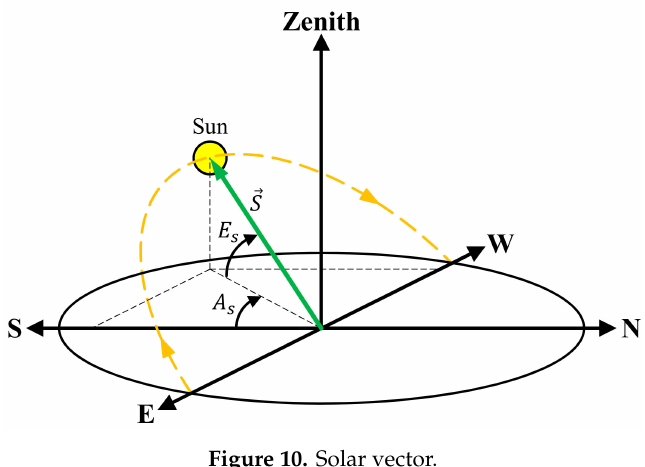
Figure 10. Solar